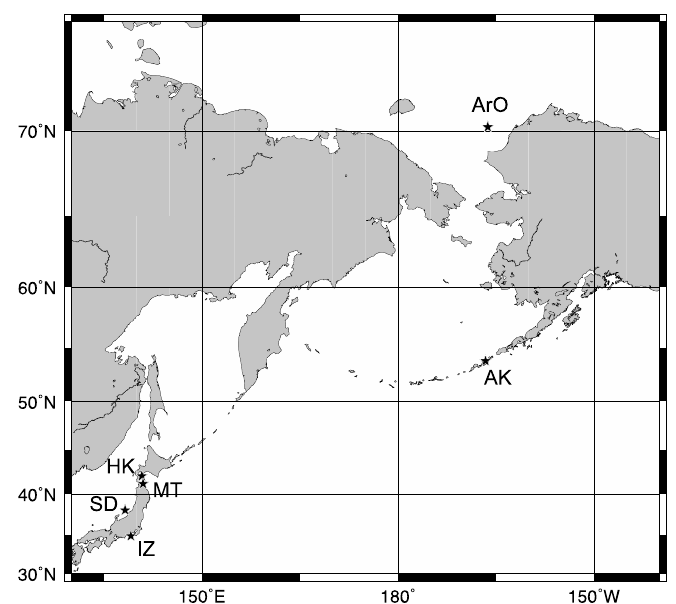
Figure 1. Sampling locations are represented with stars. ArO: the Arctic Ocean, AK: Alaska, HK: Hokkaido, MT: Mutsu, SD: Sado Island, IZ: Izu. Table 1. Sampling locations and antifreeze activities. SBT: Sea bottom temperature (°C), N : number of species.